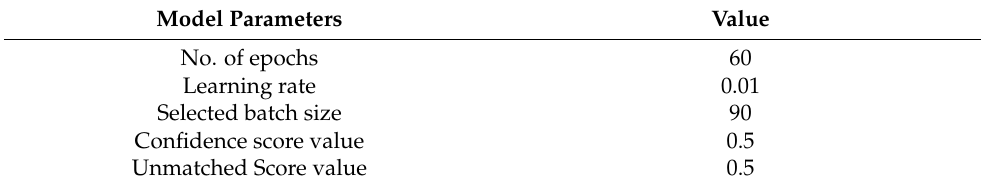
Table 2. Training parameters of the proposed